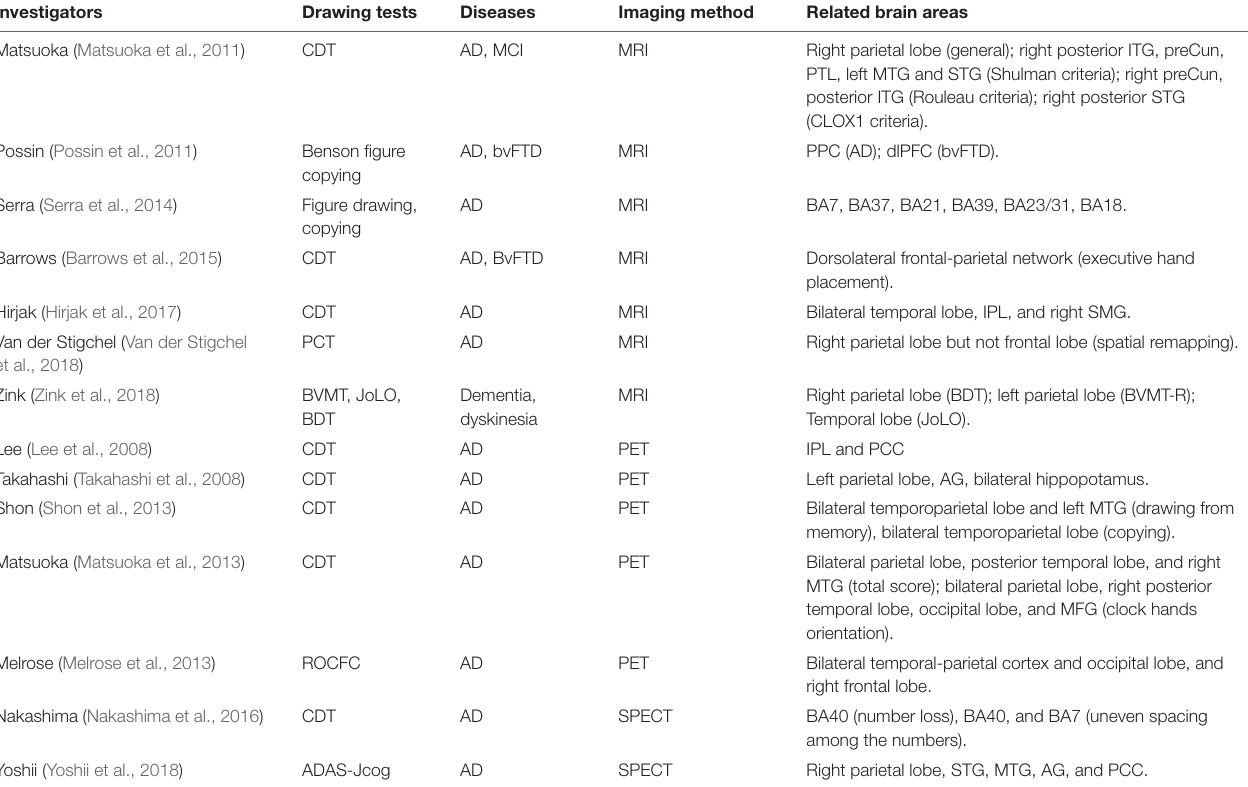
TABLE 3 | Correlations between the PPC and drawing deficits in patients with global brain injury. Investigators Drawing tests